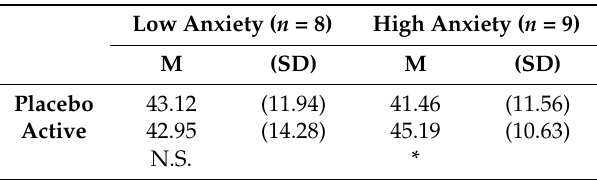
Table 5. Resting state posterior alpha activity for MEG participants divided by trait anxiety (Mean (M) and